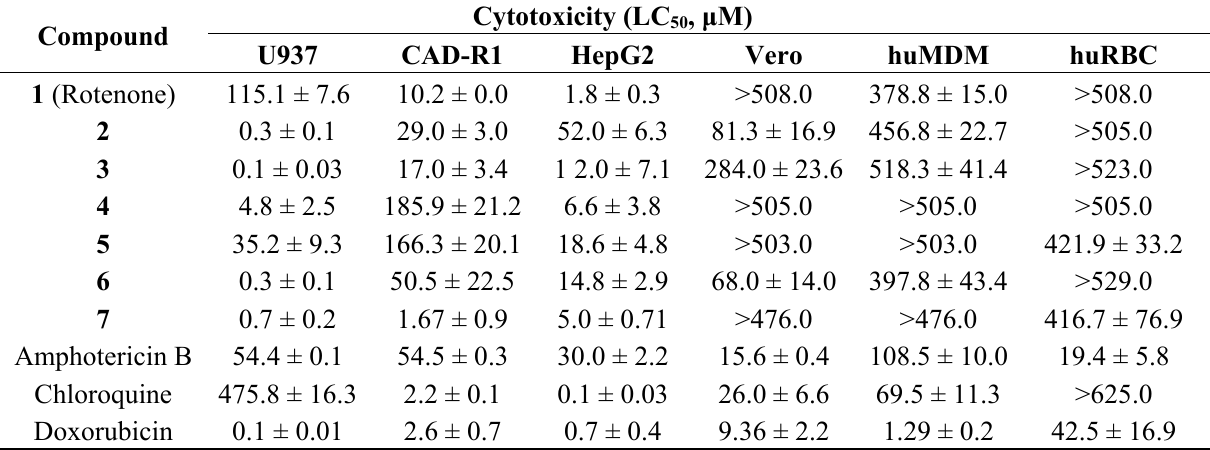
Table 1. In vitro cytotoxicity of rotenone and its derivatives . huMDM, human monocyte-derived macrophages.